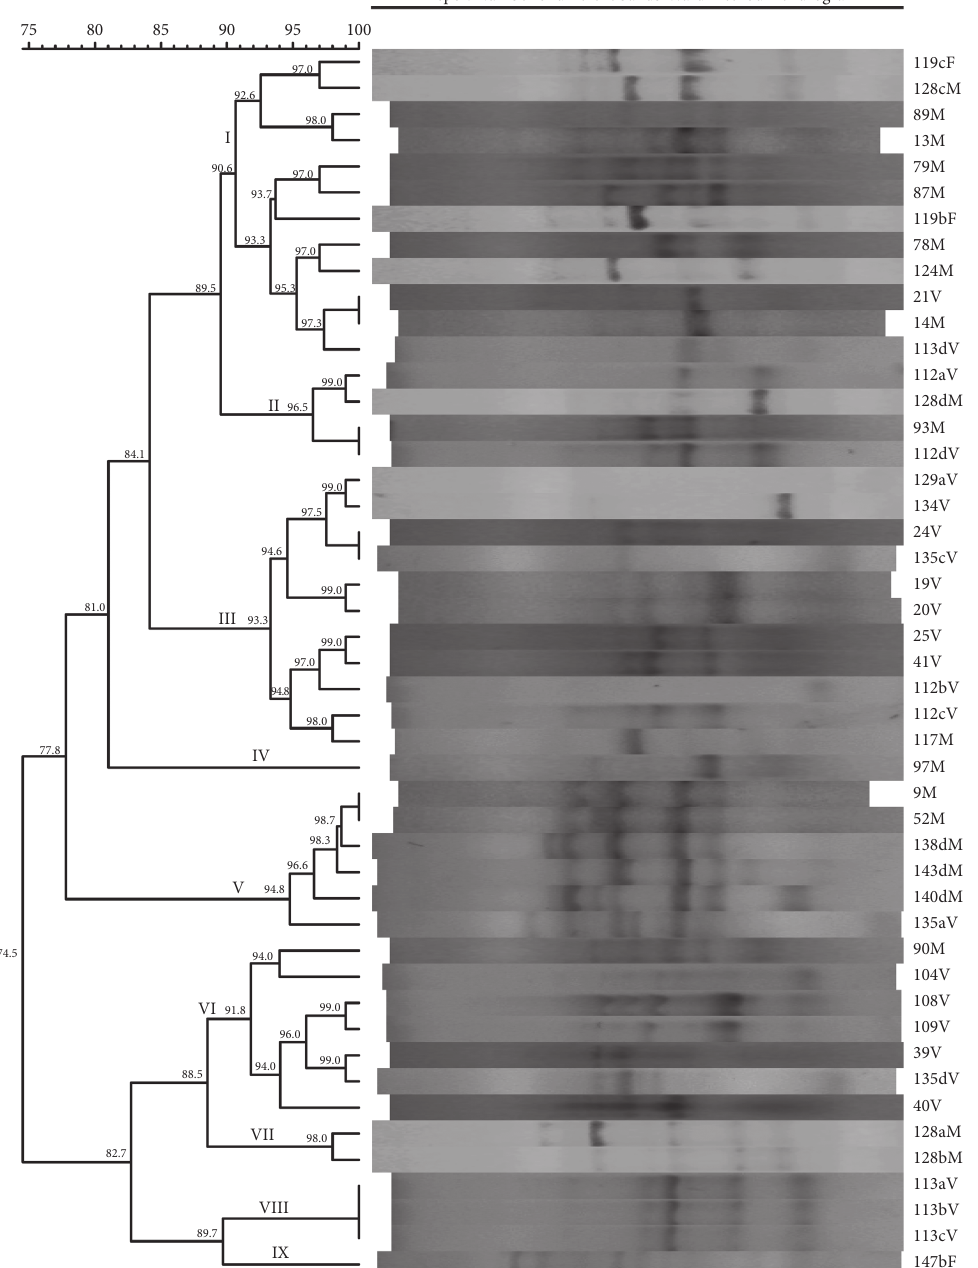
Figure 3: Dendrogram showing ERIC-PCR band patterns, clusters, and genetic similarity of E. coli isolates from different sources identified as follows: M, isolate from manure; V, isolate from vegetable; F, isolate from fish; a, b, c, d, multiple isolates from a sample; (I–IX), identified